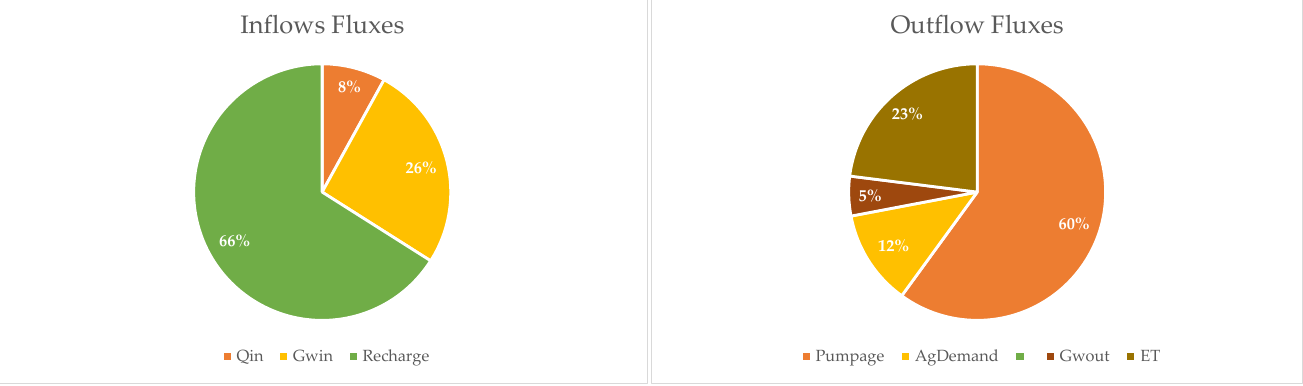
Figure 4. The 1954–2020 average inflow and outflow fluxes for maintaining sustainable conditions. The fluxes estimated for the WBM can be grouped to three general categories: climate driven annually variable fluxes (Q in , Q out , Re), satisfying water demand fluxes (Ag, Pu), and constant annual fluxes (GWin, GWout, ET). The first category is based on a hydrologic model that uses sub-daily precipitation and evapotranspiration demand time series as in- put to simulate the fluxes needed for the WBM. While the simulated Q in and Q out were compared to observed streamflow records, the Re estimate cannot be compared to obser- vations. As discussed in the results section, the Re is the largest flux into the basin (Figures 3 and 4) and has large inter-annual variability (Table 2). Considering moving averages of 20-year intervals, the estimated Pu is shown in Fig- ure 5b (average Pu of 26.3 MCM/year (ranging from 8.1 to 36.8 and an S.D of 9.6 MCM/year). As expected, the estimated 20-year annual Pu has continuously declined since the mid-1990s to approximately 9 MCM/year since 2012.